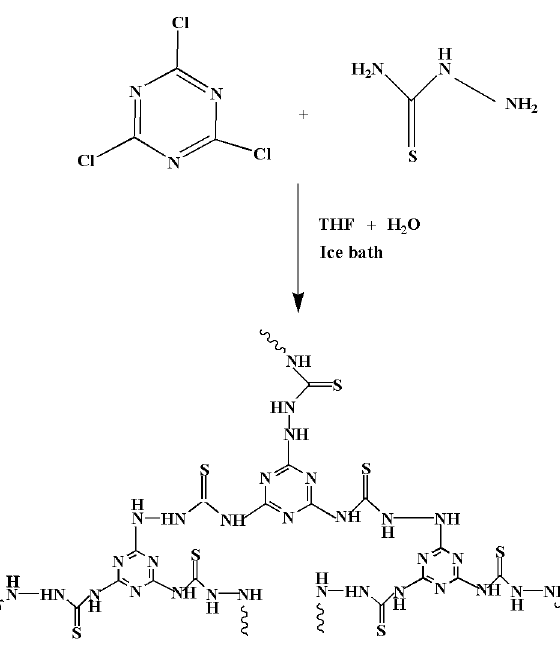
Scheme 1. The synthesized process of cyanuric-thiosemicarbazide chelating resin.